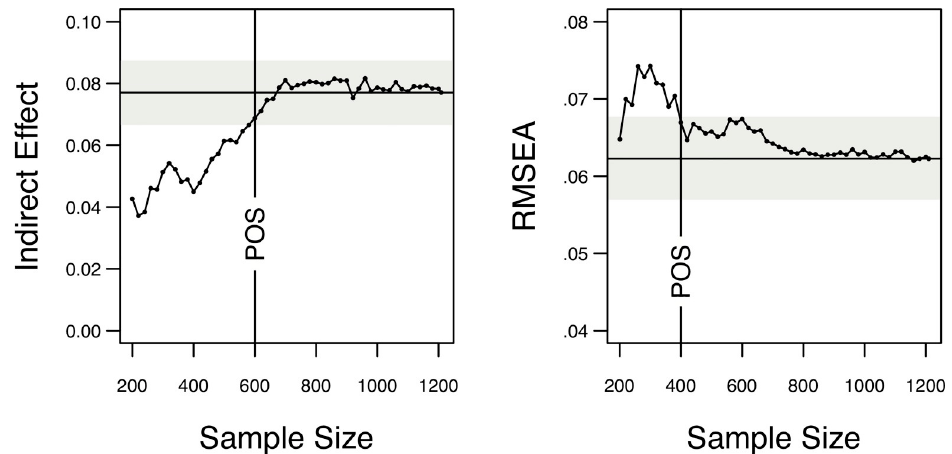
Fig 4. Evolution of coefficients with increasing sample size. Horizontal line = final effect in the total sample. Grey area = corridor of stability. POS = point of stability, i.e., sample size after which the indirect effect did not leave the corridor of stability anymore. Models were fit with sample size starting at n = 200 and then increasing by n = 20 until the final sample size of N = 1209 was reached. Left panel: Evolution of the indirect effect of Need for Cognition on Self- Control via Action Orientation in the partial mediation model, where the corridor of stability is the final effect together ± its final standard error. Right panel: Evolution of the Root Mean Error of Approximation (RMSEA) as fit measure, where the corridor of stability is the 90% confidence interval of